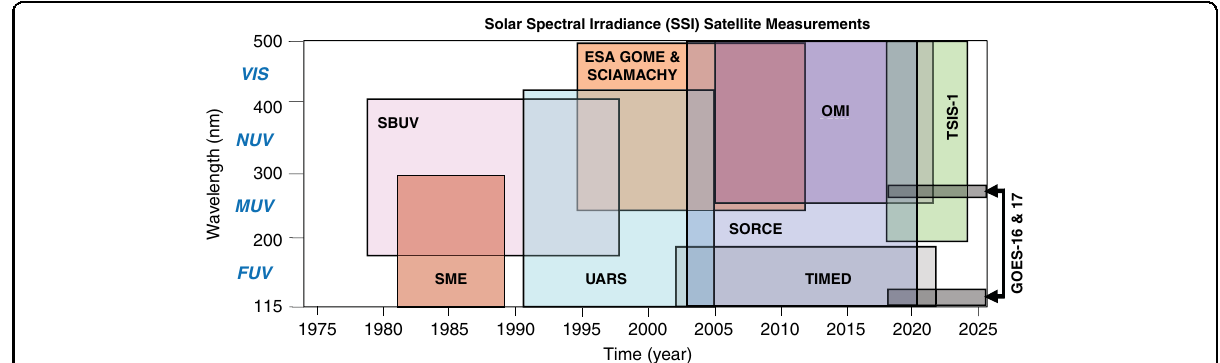
Fig. 1 History of space-based daily observations of SSI in the ultraviolet- and visible-wavelength domain. In addition, several rockets fl ights and Shuttle missions were made for different aims of calibration and validation. The SOLAR platform composed of three instruments (SOLSPEC, SolACES, and SOVIM) was placed on the International Space Station and operated from 2008 to 2017. SOLAR measured the SSI from the EUV to near IR (3000 nm), Courtesy of Tom Woods